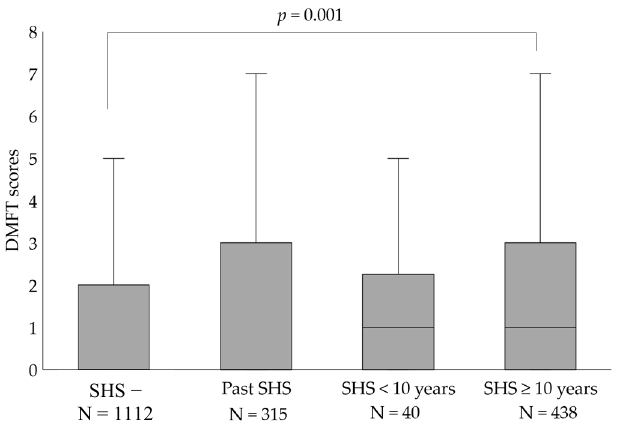
Figure 1. Comparison of DMFT by the presence/absence of household exposure to secondhand smoke. DMFT scores were significantly higher in the current SHS ≥ 10 years than those in the SHS − . Kruskal–Wallis test and Dunn test with Bonferroni correction. DMFT, decayed, missing and filled teeth; SHS, secondhand smoke.